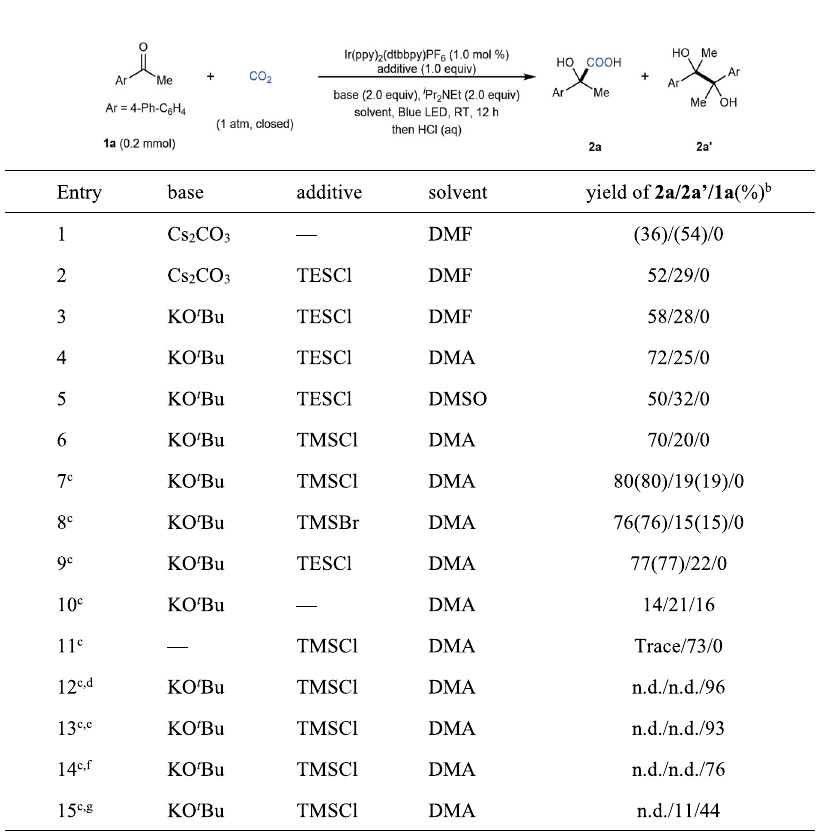
Fig. 3 Reaction optimization. a Reaction conditions: 1a (0.2 mmol), Ir(ppy) 2 (dtbbpy)PF 6 (1.0 mol %), base (2.0 equiv), i Pr 2 NEt (2.0 equiv), additive (1.0 equiv) in solvent (2.0 mL) at room temperature (RT) in CO 2 atmosphere under irradiation with 30 W blue LED for 12 h. The corresponding reductive product alcohol, 1-([1,1 ′ -biphenyl]-4-yl)ethan-1-ol 2a ″ , was observed as a minor byproduct in generally lower than 10% yield. b Yields were determined by UPLC analysis with 1,1 ′ -biphenyl as internal standard. The isolated yields are given in parentheses. c Chlorosilane (1.3 equiv). d Without light. e Without Ir (ppy) 2 (dtbbpy)PF 6 . f Without i Pr 2 NEt. g Under N 2 atmosphere. n.d. not detected, LED light-emitting diode, DMSO dimethyl sulfoxide, dtbbpy 4,4 ′ -di- tert - butyl-2,2 ′ -bipyridine, ppy 2-phenylpyridine, TMS trimethylsilyl.